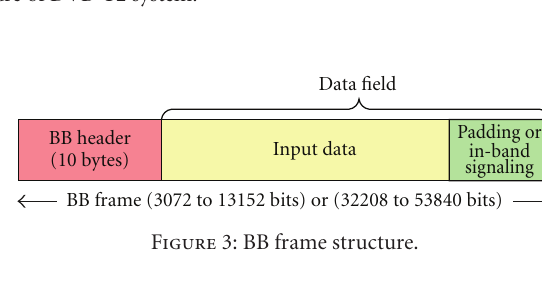
Figure 1: High level architecture of DVB-T2 system.